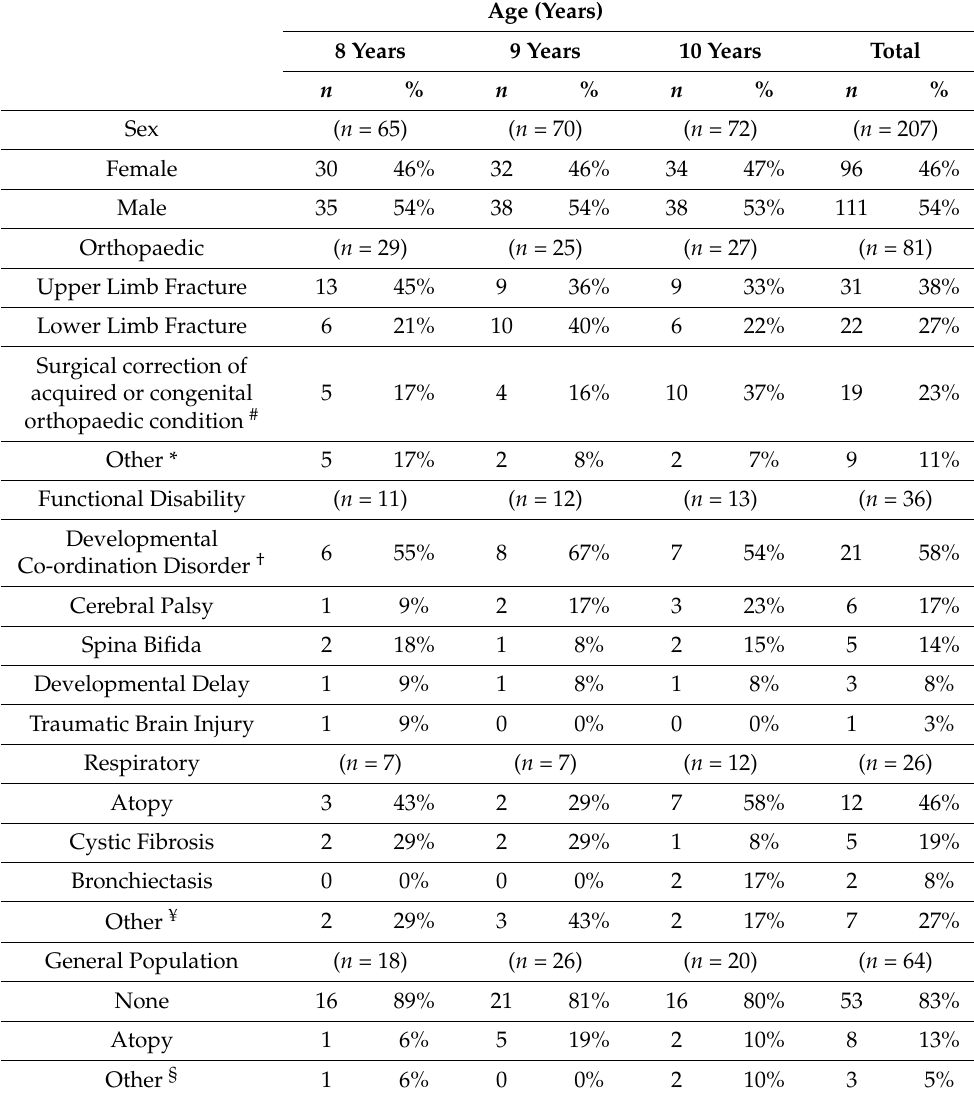
Table 2. Descriptive statistics of participants aged 8–10